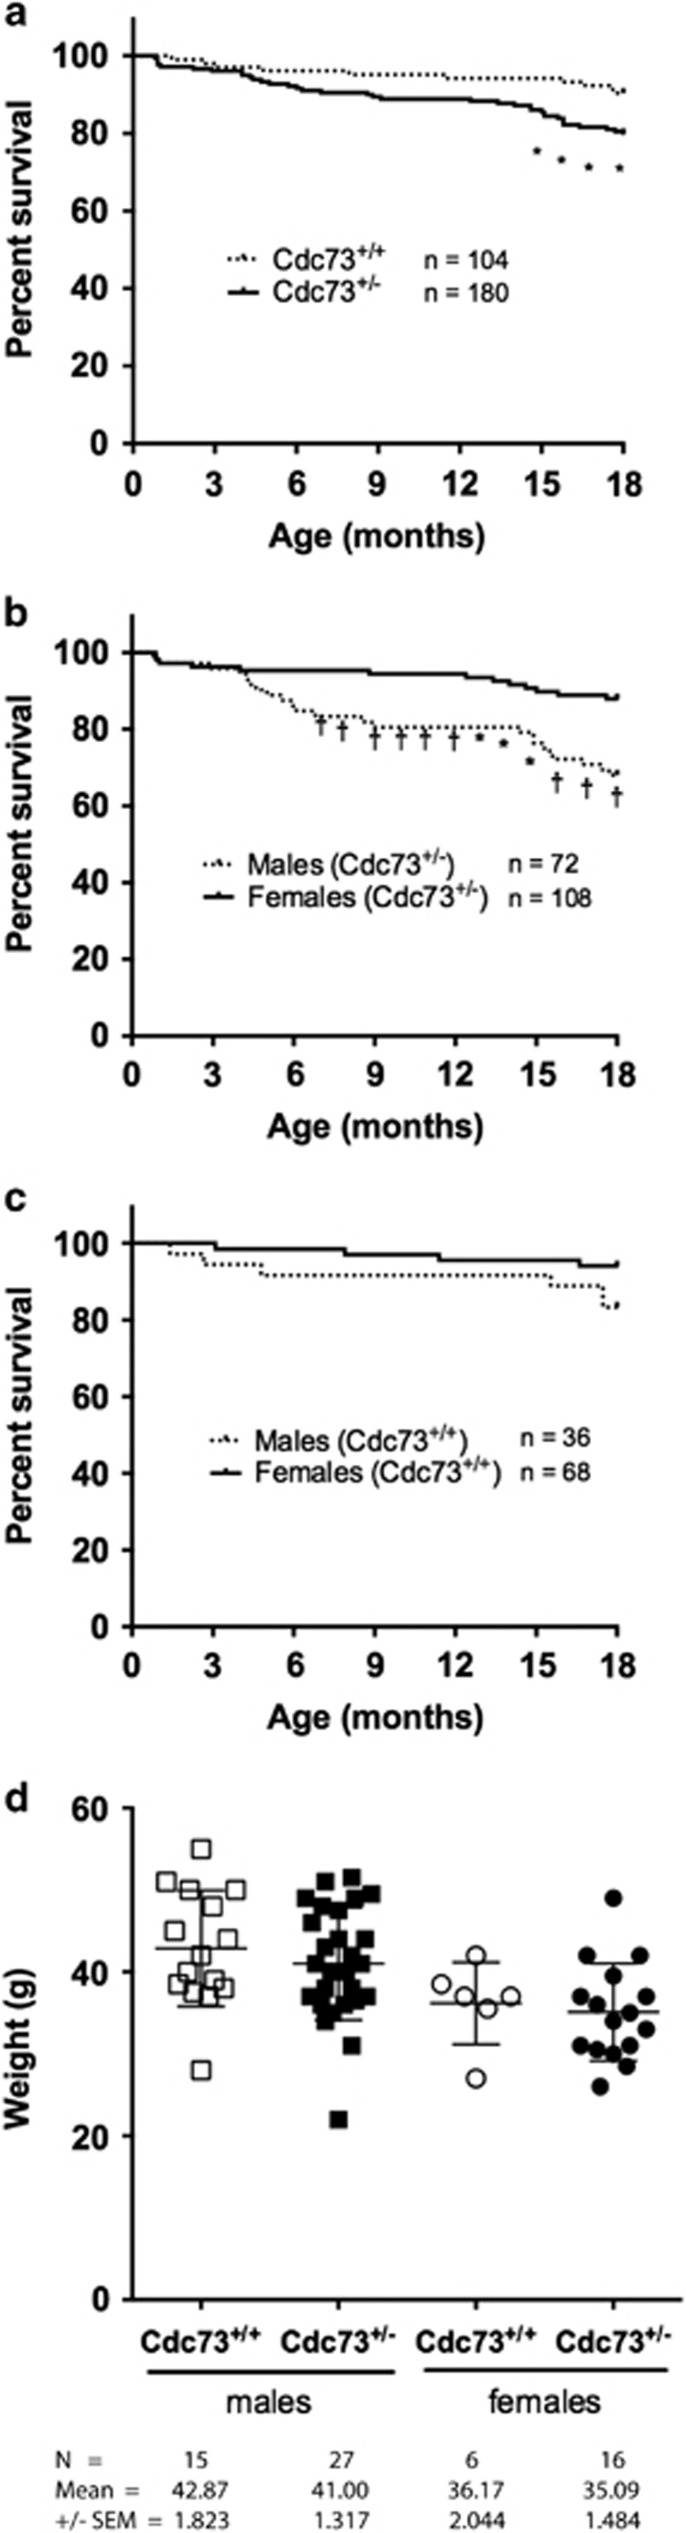
Survival and weights of Cdc73+/+ and conventional Cdc73+/− knockout mice. (a) Survival of Cdc73+/+and Cdc73+/− mice (data for male and female mice combined) over 18 months. Kaplan–Meier analysis revealed significantly lower survival in Cdc73+/− mice when compared to Cdc73+/+ mice (80 versus 90%, Log-rank Mantel Cox test, P<0.05). Moreover the reduced survival in the Cdc73+/− mice was observed from 15 months of age (*P<0.05, Fisher’s exact test). (b) Kaplan–Meier analysis showed that Cdc73+/− males had significantly reduced survival than Cdc73+/− females (Log-rank Mantel Cox test, P<0.005), which was observed from the age of 7 months (*P<0.05, †P<0.01, Fisher’s exact test). (c) Kaplan–Meier analysis showing that survival of male and female Cdc73+/+ mice was similar. Moreover, the survival of Cdc73+/+ male mice did not differ significantly (P=0.094) from that of Cdc73+/− male mice (see above). (d) Bodyweights at 18 months of age of Cdc73+/+and Cdc73+/− mice, showing that the mean bodyweights of Cdc73+/+and Cdc73+/− males, and of Cdc73+/+and Cdc73+/− females were similar.